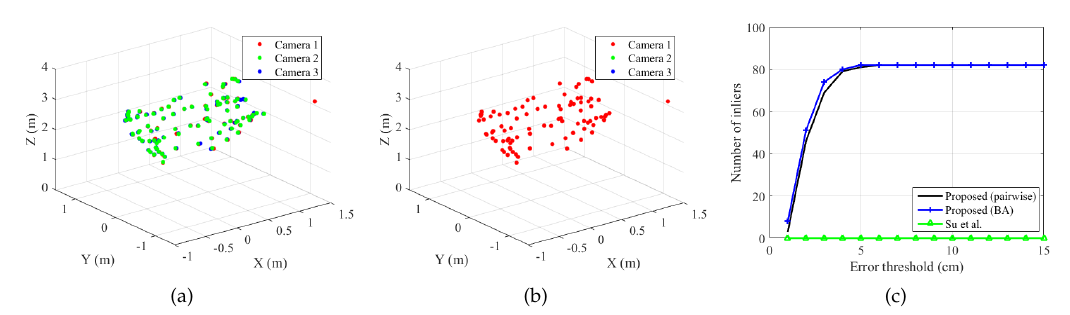
Figure 20. Aligned sphere centers and number of inliers (static basketball set, N = 101). ( a ) Proposed method (BA). ( b ) Su et al. [20]. ( c ) Number of inliers. Refer to the text for more detail. Best viewed in